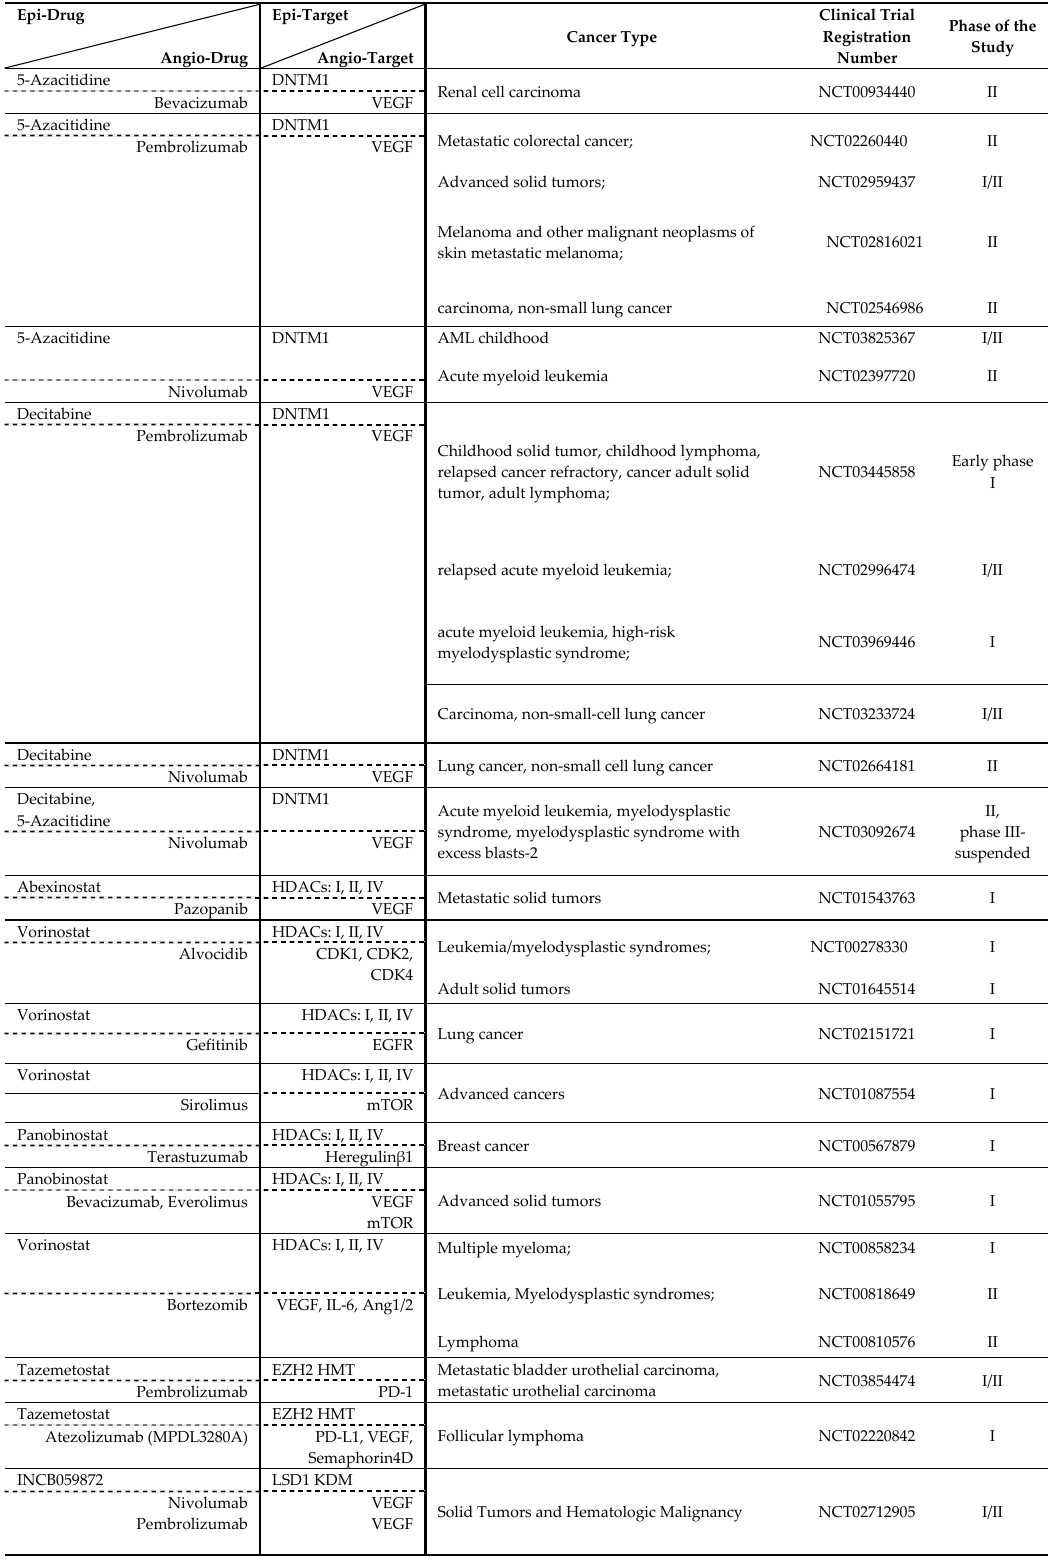
Table 3. Targeting tumor by combined therapy based on epigenetic and angiostatic drugs.